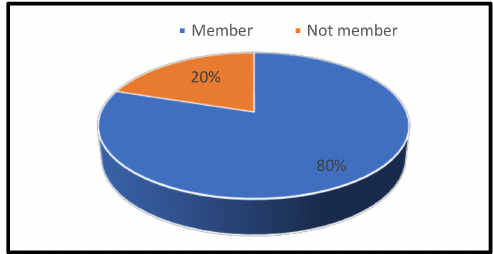
Figure 3. Membership of Bangladesh Society of Seed Technology (BSST).